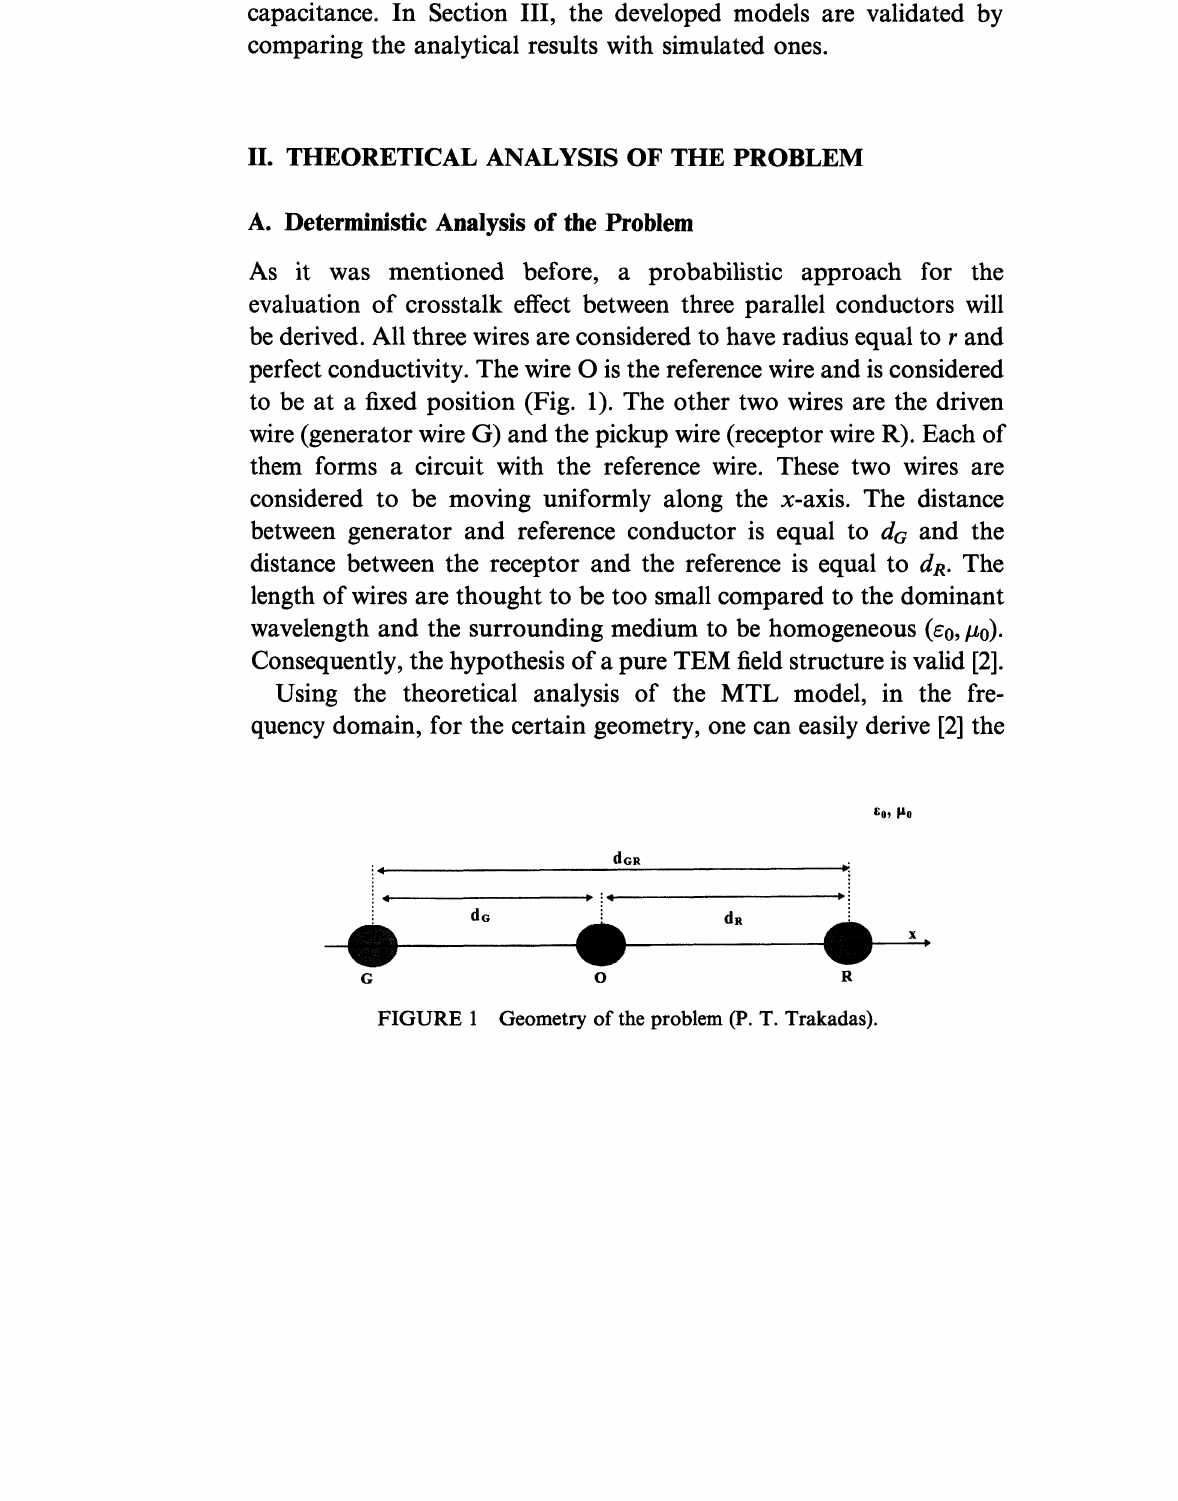
FIGURE Geometry of the problem (P. T.